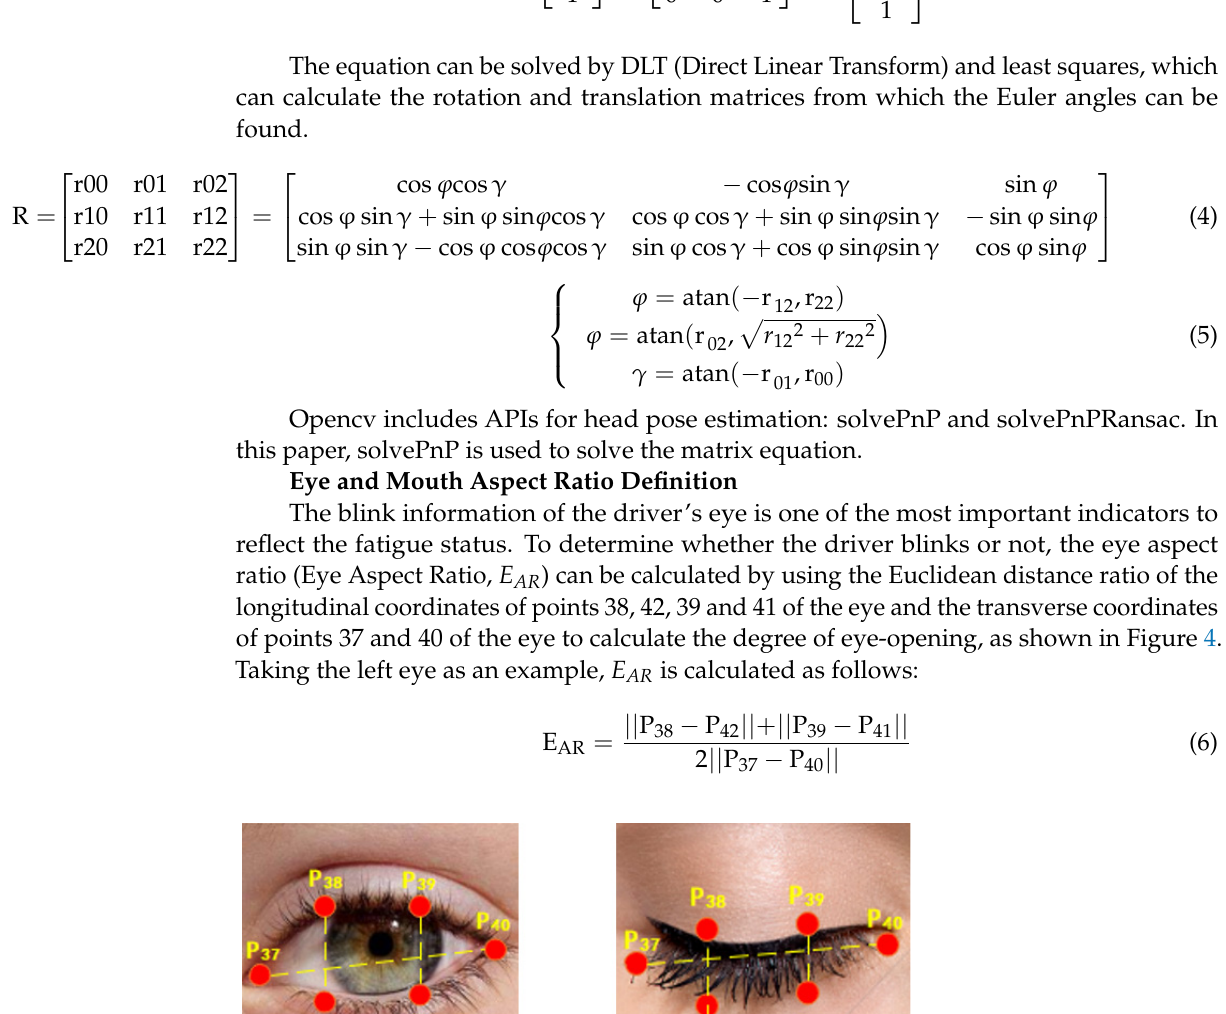
Figure 5. Mouth feature points . 3.2.2. Double-Threshold Fatigue Index Calculation Head posture, eye closure and mouth opening are all important indicators to identify driver fatigue [31–33]. In this paper, by identifying the driver’s head, eyes and mouth states, we use the double-threshold method to calculate four fatigue indicators, such as driver drowsy head nod frequency, fatigue blink frequency, yawn frequency and eye clo- sure rate and then determine the driver’s fatigue level. Header Indicator The head rotation angle is also a significant indicator of fatigue discrimination. When the driver is tired, the head will do a similar nodding or tilting posture, which mainly refers to the change of Pitch and Roll angles in the rotation vector but not much change in the Yaw direction. We can determine whether the driver has performed a head nodding or head tilting movement by comparing the angle of the Pitch or Roll change with the set threshold value.